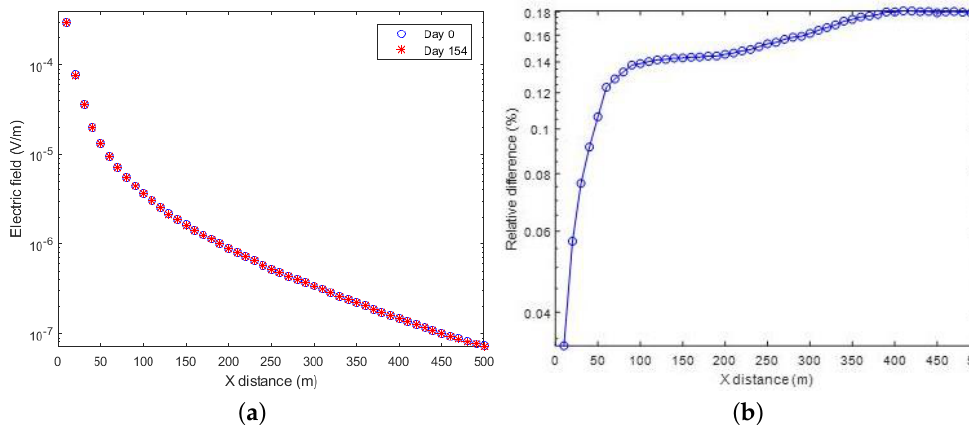
Figure 13. Comparison of electric fields between the initial time and after 154 days using the surface- to-surface configuration: ( a ) absolute values and ( b ) their relative difference.